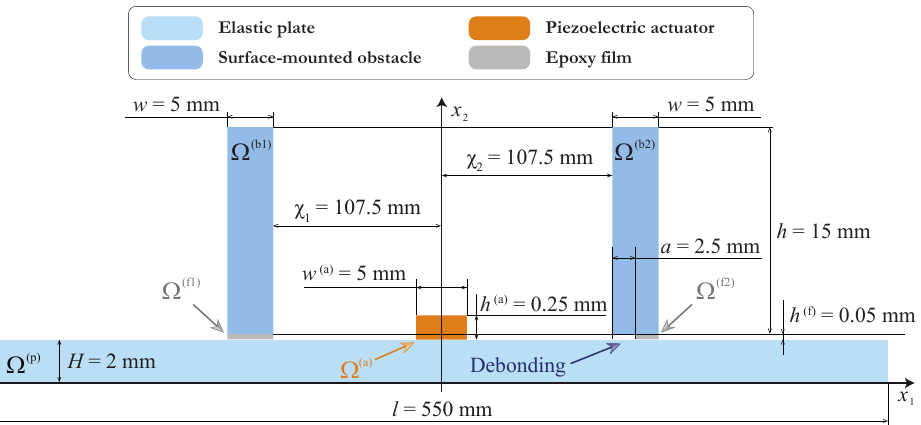
Figure 3. The geometry for the boundary value problem corresponding to the